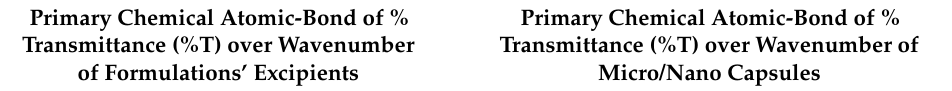
Table 1. Primary chemical atomic-bond transmittance (%T) of formulation excipients (top, left) and micro/ nano capsules (top, right) as attained through FTIR.